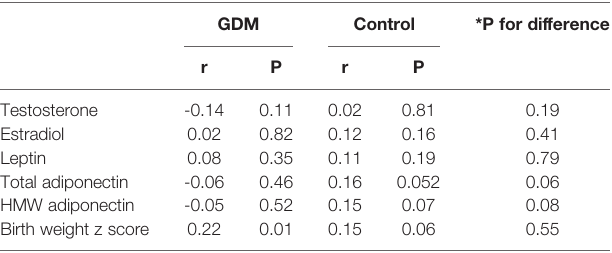
TABLE 5 | Cord blood FABP4 in correlations with testosterone, estradiol, leptin, adiponectin and birth weight z score in GDM and euglycemic (control) pregnancies. GDM Control *P for difference